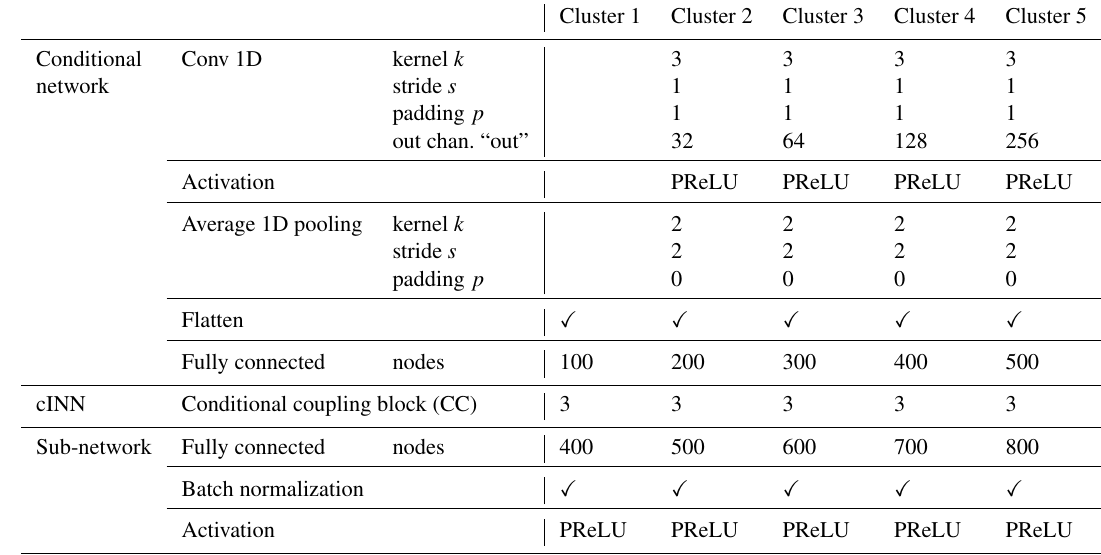
Figure 4. Conditional invertible neural networks (cINNs, in blue frame) with sequentially connected conditional coupling blocks (CCs). The conditional feed-forward network (cond. net, in orange frame) preprocesses the condition y with 1D convolutional layers and PReLU (parametric rectified linear unit) activations. Average 1D pooling is performed on the output before it is flattened and reduced in dimensions with a fully connected layer (fc-layer) to be then fed into the sub-networks of the CCs. The convolutions gradually increase in size in order to progressively extract higher-level features from the condition c . Table 3. Hyperparameter set of the complete network, including conditional network, conditional invertible neural networks (cINNs), and sub-network. The cINN is divided into five clusters, for which the hyperparameters are listed separately. In Cluster 1, the conditions are directly fed into the conditional coupling blocks (CCs), without a prior convolutional layer (see Fig.